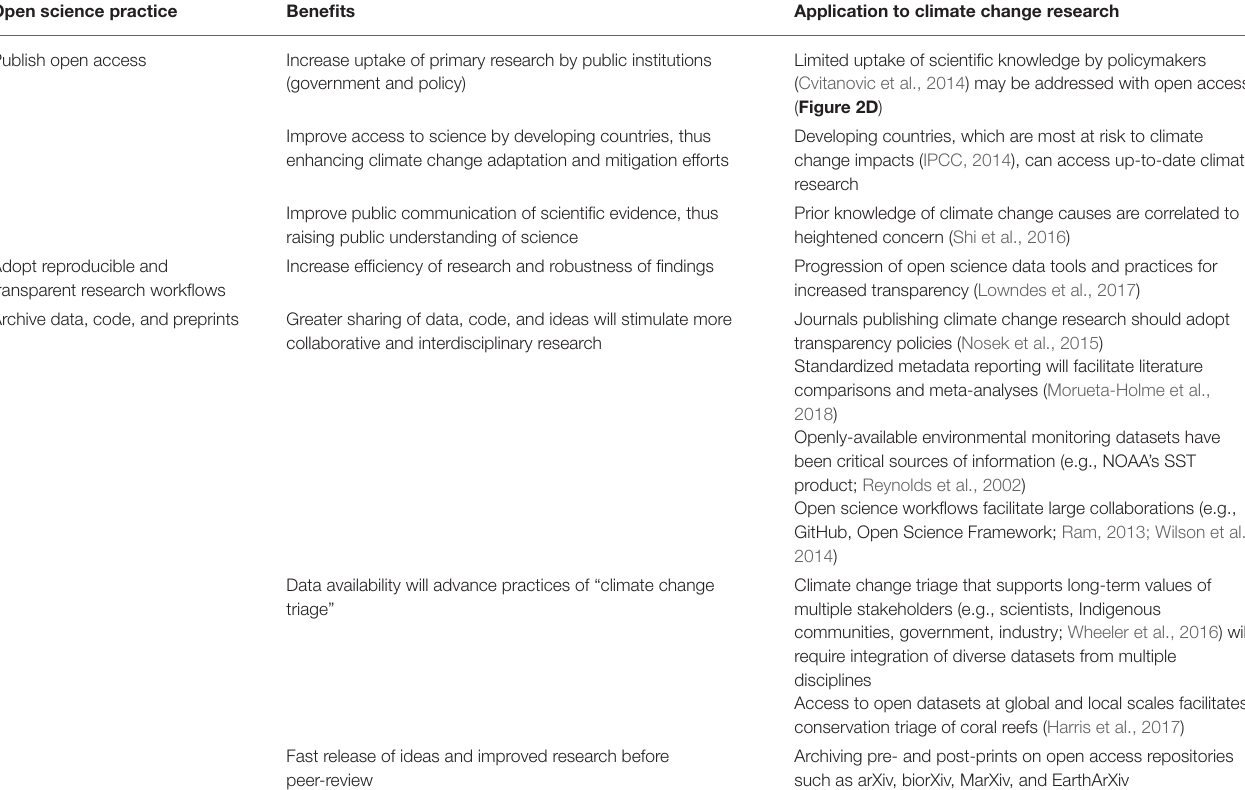
TABLE 1 | Recommendations to advance climate change research with open science